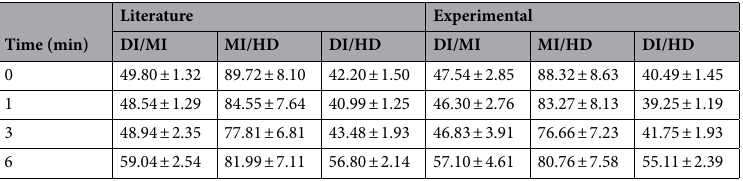
Table 5. SE estimations based on OW method at different UV/O 3 treatment timeframes.